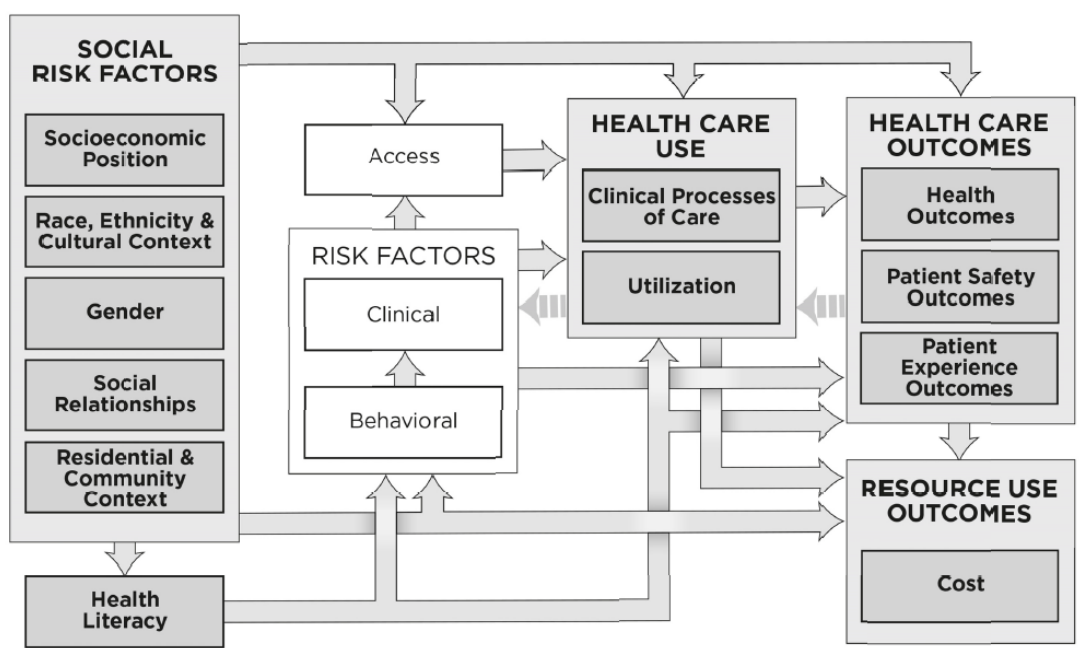
Figure 2.1. National Academies of Sciences, Engineering, and Medicine’s Conceptual Framework of Social Risk Factors for Healthcare Use, Outcomes, and